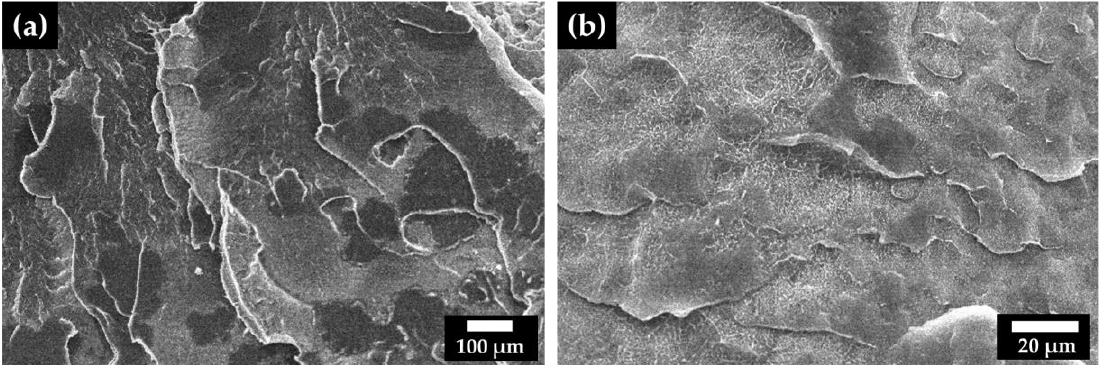
Figure 8. SEM micrographs of the cryogenic fracture surface of the blends: ( a ) 30 UHMWPE and ( b ) 45 UHMWPE.